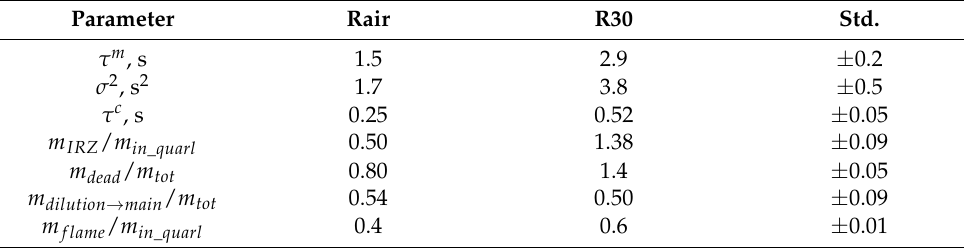
Table 4. Selected properties of the CRN model: reactive case.